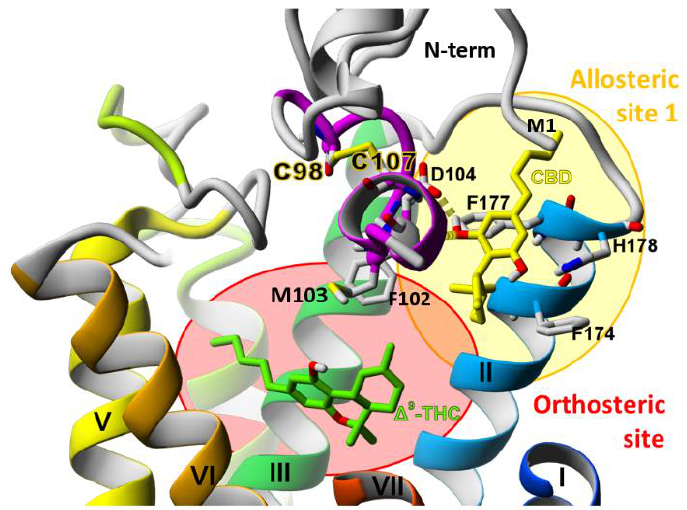
Figure 10. CBD and THC binding to CB 1 R. CBD is bound to the allosteric site 1 while ∆ 9 -THC is bound to the orthosteric site. The allosteric site is located very close to the orthosteric binding site and they partially overlap one another. The MPR (purple) constitutes a barrier between the orthosteric and the allosteric binding sites. CBD bound to the allosteric binding site forms a hydrogen bond with D104 and π - π interactions with